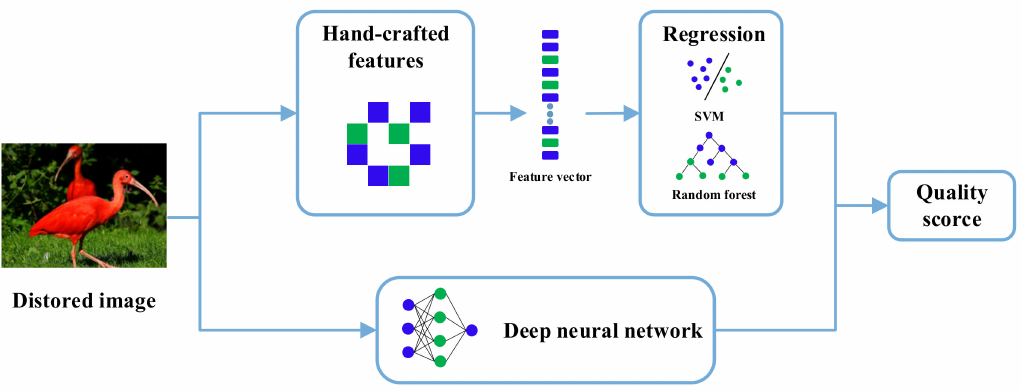
Figure 4. The general process of traditional no-reference image quality assessment